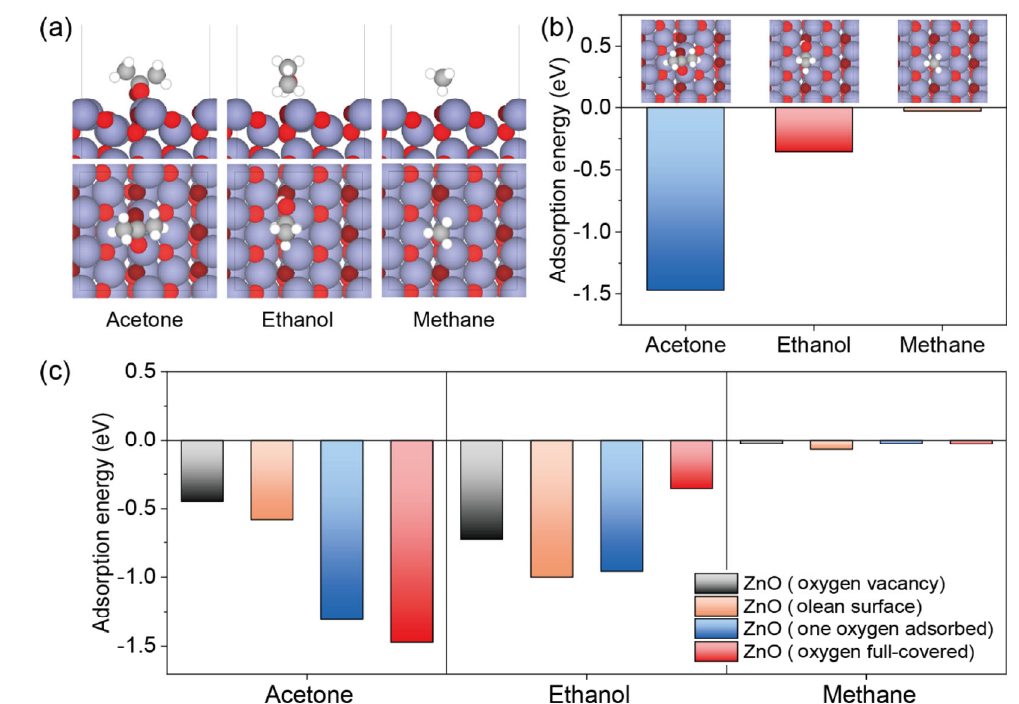
Fig. 12 (a) Optimized adsorption configurations of acetone, ethanol, and methane on oxygen ion species full-covered ZnO(101¯0) surface in the cross-section view (upper panel) and the top section view (lower panel). Zn, lattice O, adsorbed O, C, and H atoms are shown as medium-purple, red, dark-red, grey, and white spheres, respectively. (b) Plot of adsorption energy ( Δ E ads ) corresponds to each configuration of (a). (c) Δ E ads plot of each gas molecule on the ZnO depending on the various surface conditions: oxygen-vacant surface, clean surface, one oxygen-adsorbed surface, and oxygen full-covered surface. as mentioned in the sensing mechanism part of Fig.